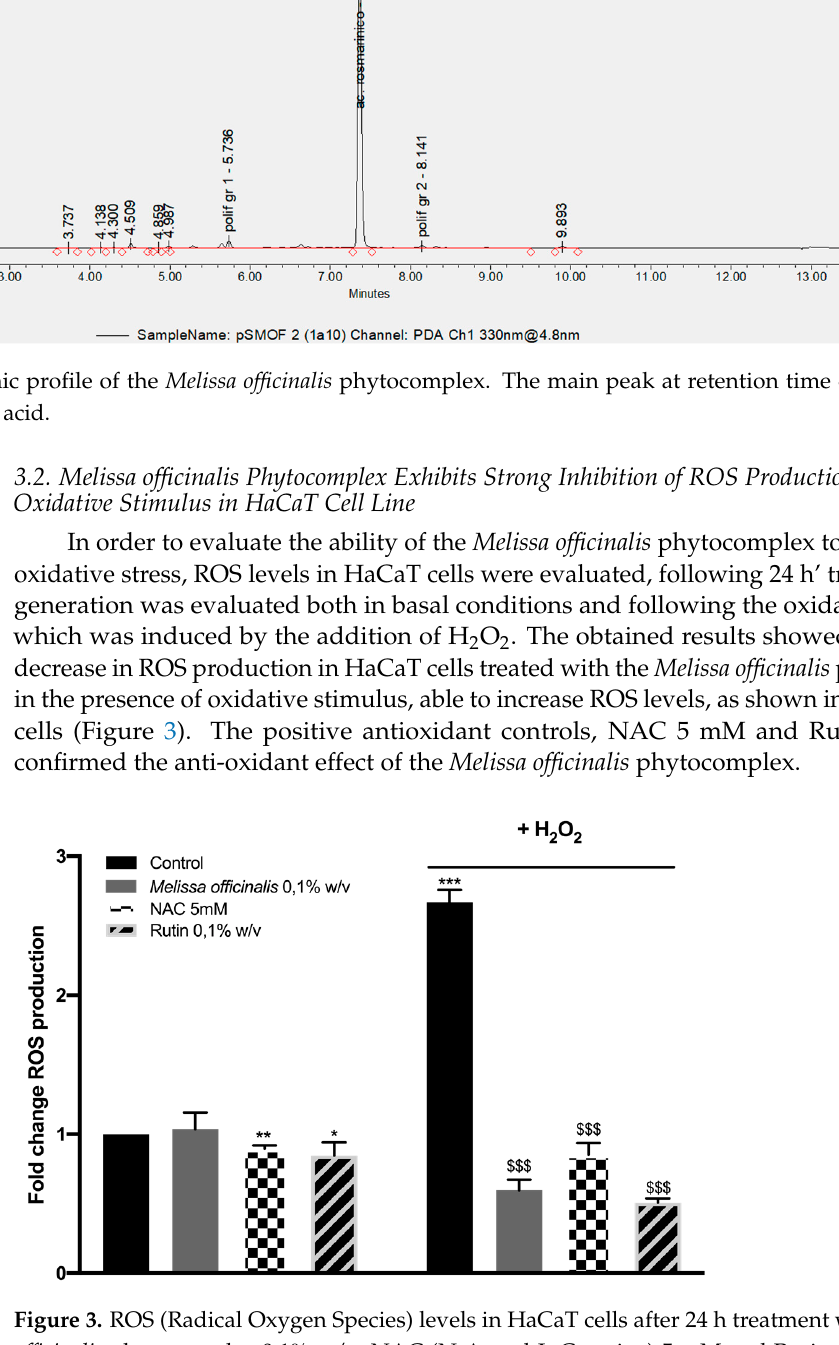
7 of 14 Figure 1. Melissa officinalis cell culture maintained in solid MO medium: ( a ) cells of the Melissa officinalis seen under an AXIO-Imager A2 optical microscope (ZEISS), in the bright field mode ( b ) and after staining with fluorescein diacetate ( c ). The content of rosmarinic acid and total polyphenols in the cell line was optimized using a MO final liquid culture medium with a higher content of sucrose (35g/L) and with a lower concentration of growth hormones (0.5 mg/L of NAA, 0.5 mg/L of IAA, and 0.25 mg/L of K). The cells grown into MO final liquid culture medium were used to prepare the Melissa officinalis phytocomplex. The UPLC-DAD analysis was used to estimate the